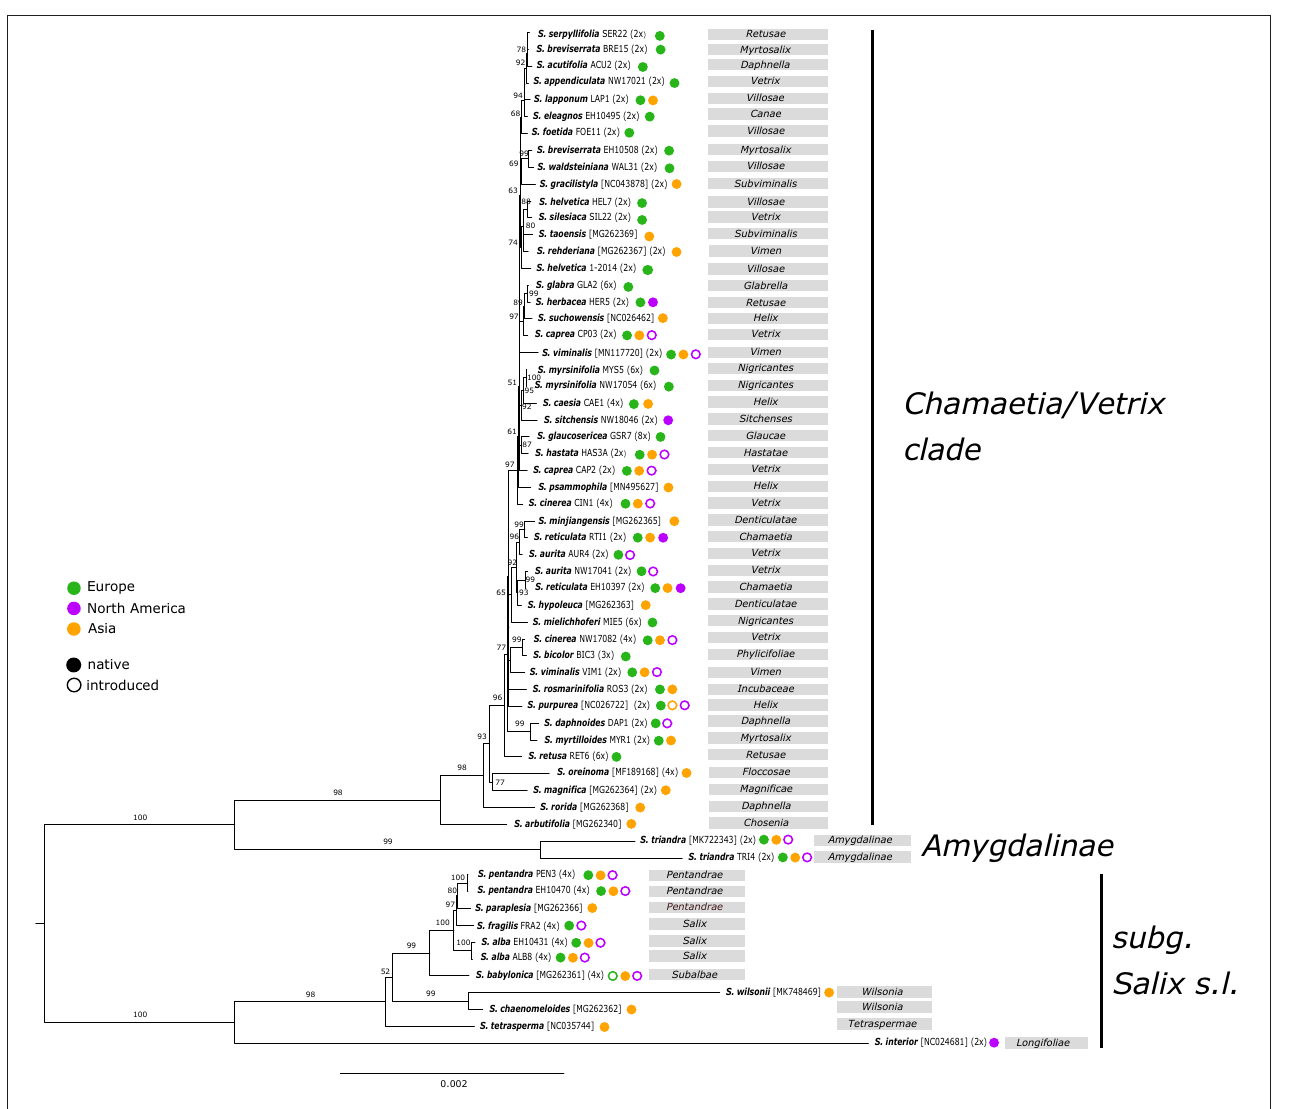
FIGURE 1 | RAxML phylogeny based on complete plastomes of 61 samples representing 50 Salix species. Sample IDs or Genbank accession numbers for Genbank samples as well as ploidy levels are indicated behind species names. Bootstrap support values are given above branches. Geographic distribution of species is indicated behind sample names according to color coding. The taxonomical affiliation into sections is given in gray boxes. The two main clades are illustrated according to their subgeneric classification.